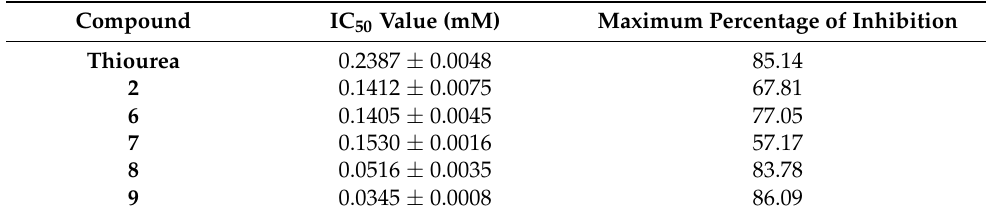
Table 1. IC 50 values and the maximum percentage of inhibitory values of thiourea and the tested oxime compounds 2 , 6 , 7 , 8 , and 9